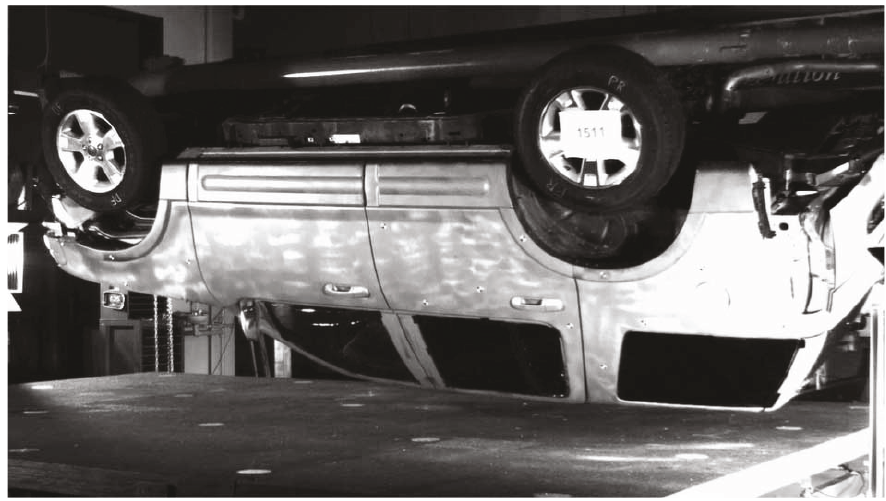
Figure 1: Rollover test at the moment of vehicle to ground contact.